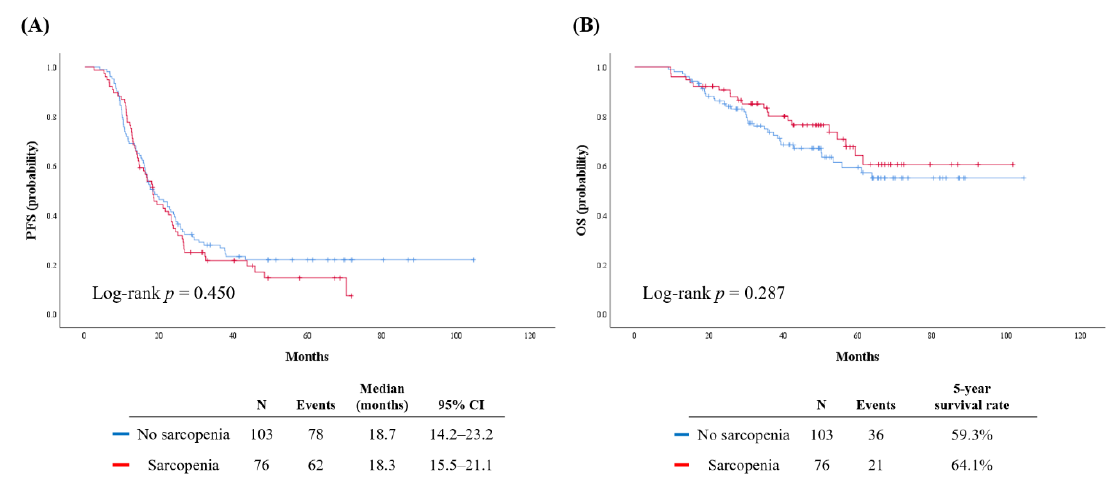
Figure 1. Survival outcomes of patients. ( A ) Progression-free survival; ( B ) overall survival. Multivariate analyses adjusting patients’ age, International Federation of Gynecology and Obstetrics (FIGO) stage, serum CA-125 levels, primary treatment strategy, residual tumor size after